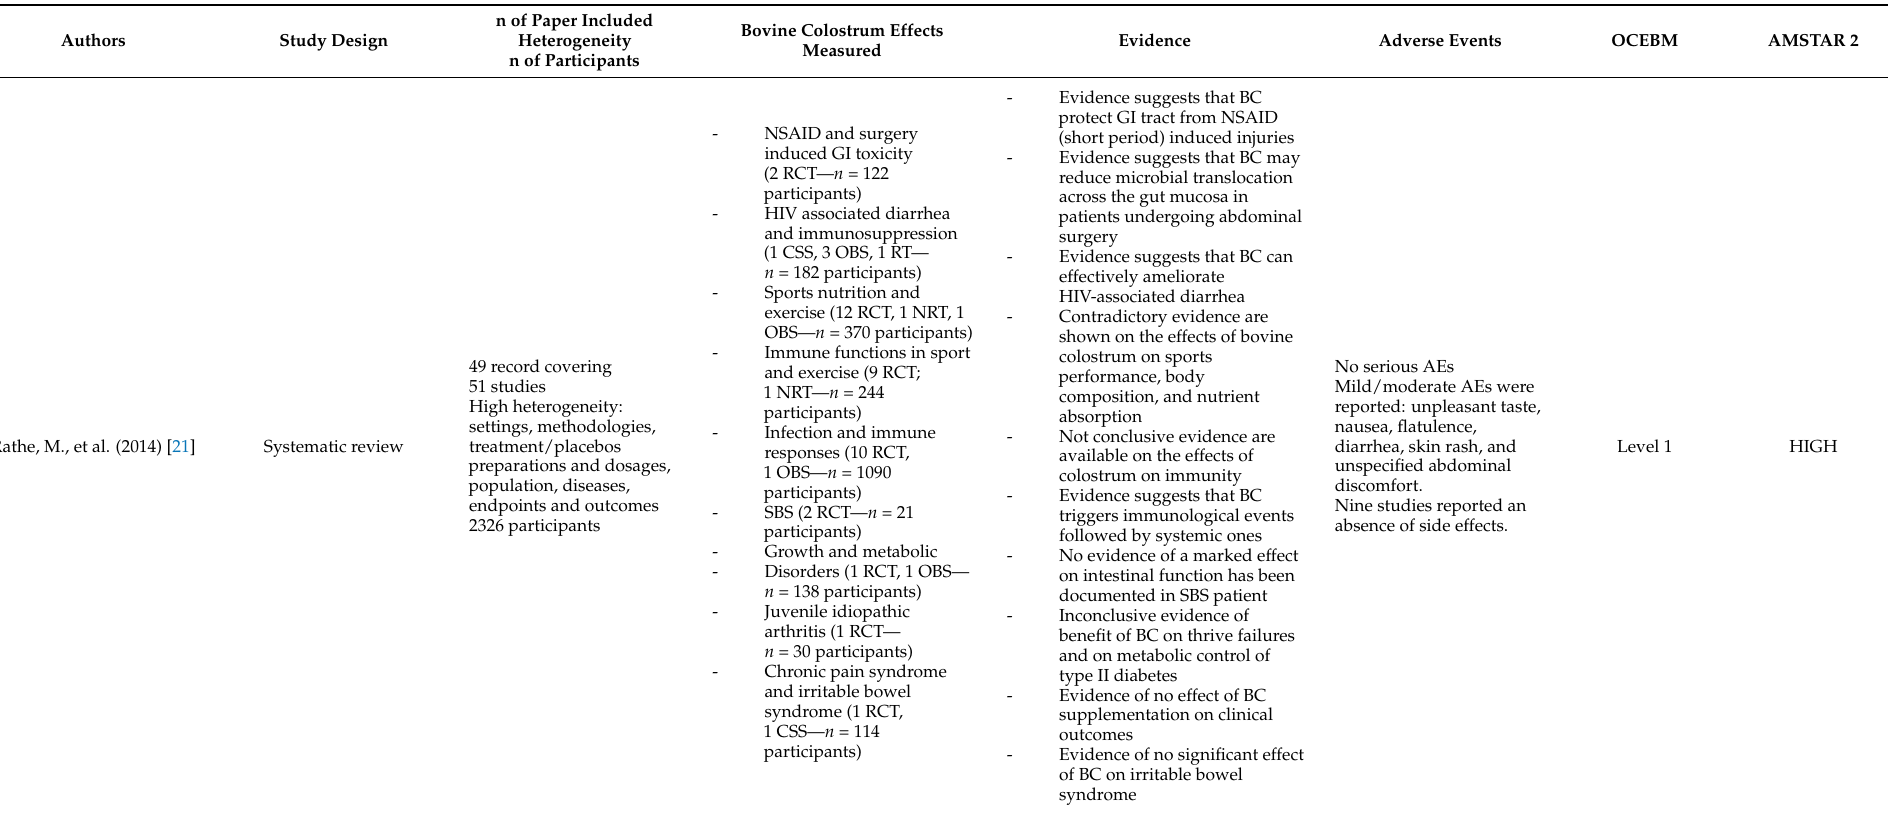
Table 8. Systematic reviews on BC clinical